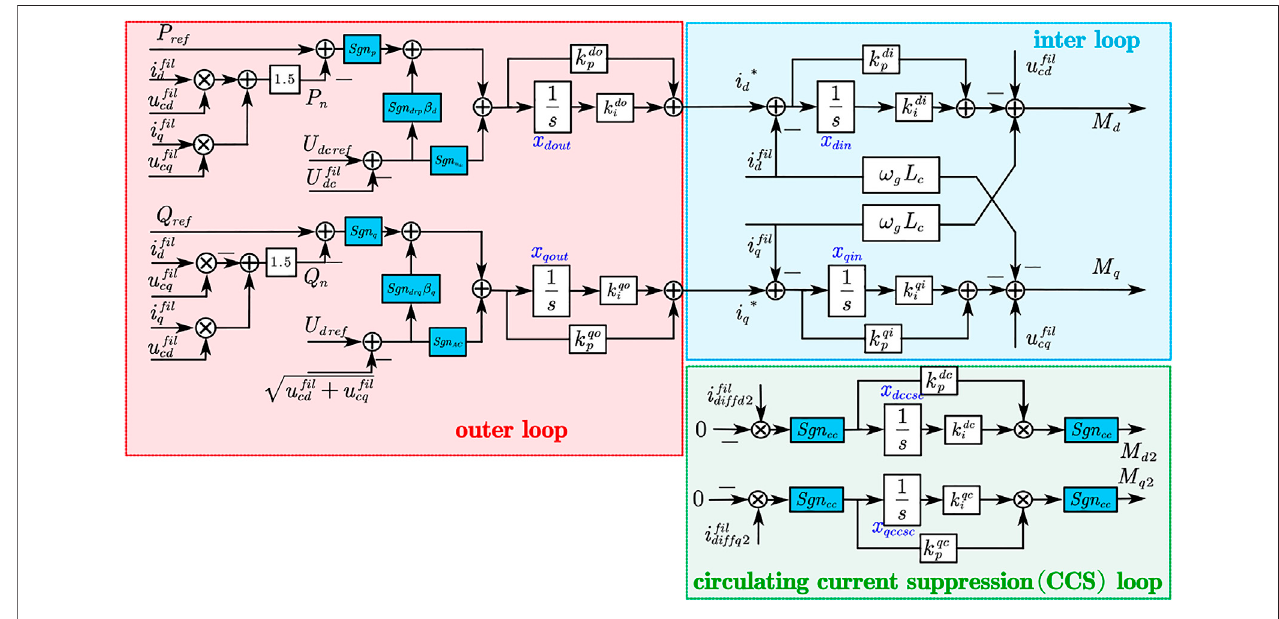
FIGURE 5 | Diagram of controller.